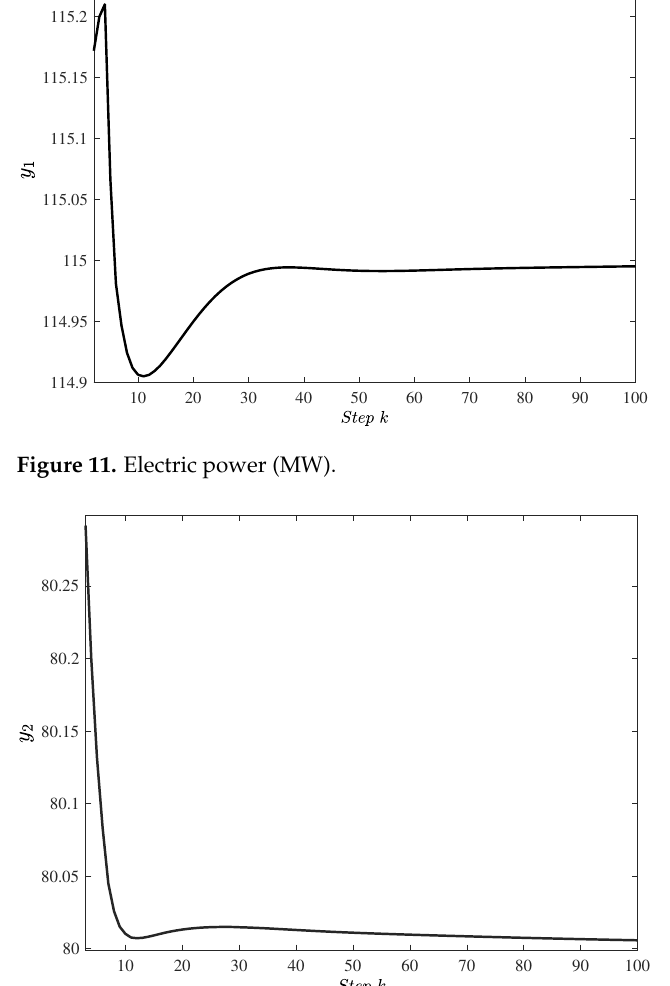
Figure 12. Drum steam pressure (kg/m 2